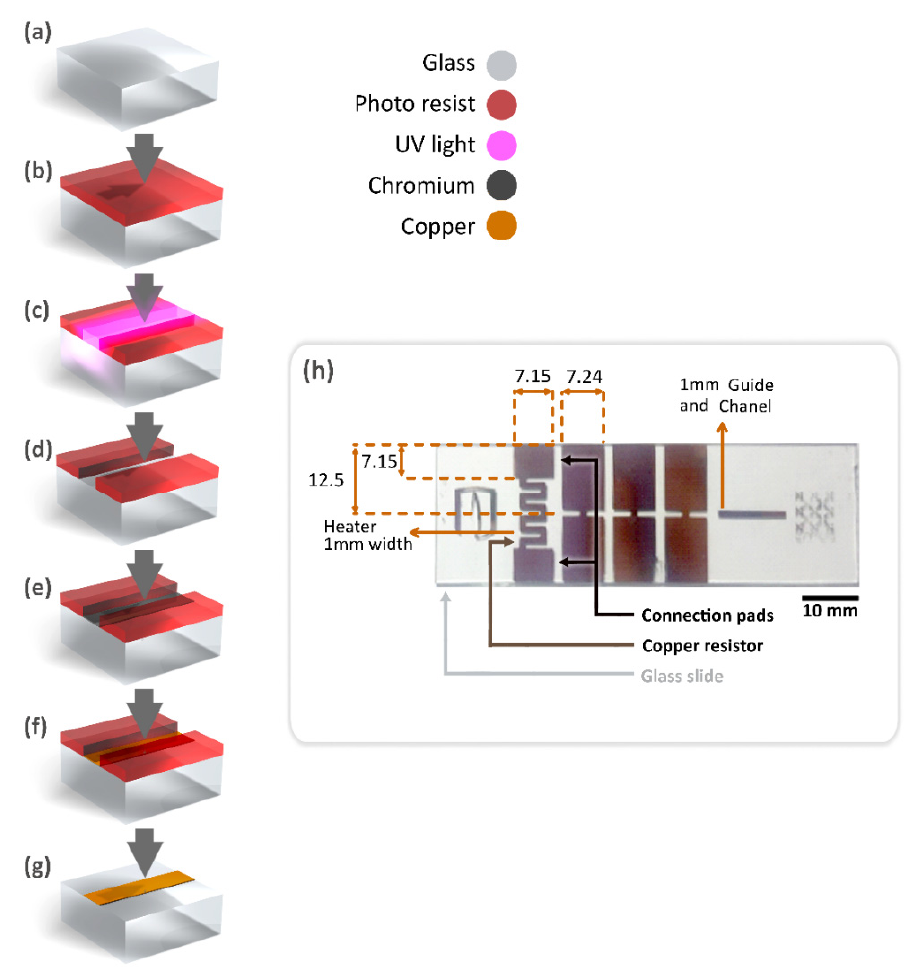
Figure 1. Fabrication process of the copper–chrome-based glass heater: ( a ) clean glass surface; ( b ) photoresist-covered glass; ( c ) UV light exposure; ( d ) photoresist development; ( e ) chrome deposition; ( f ) copper deposition; ( g ) final heater structure on glass after stripping off photoresist; ( h ) Photograph of the completed copper–chrome-based glass heater with dimensions.